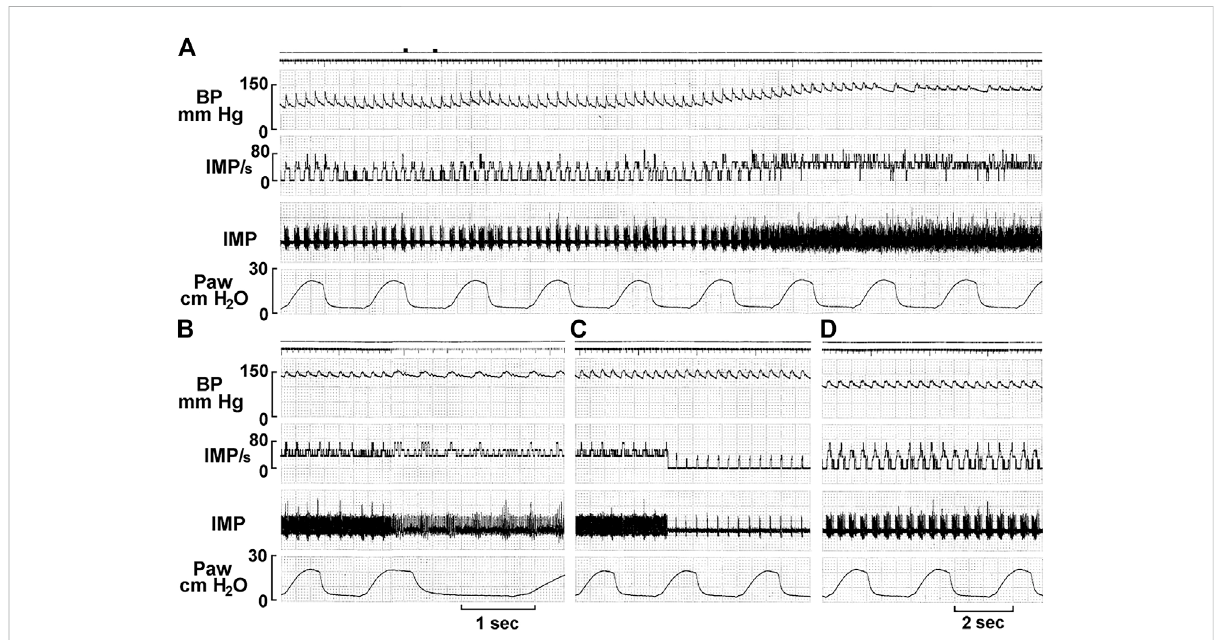
FIGURE 11 Asingleunitpossessesmultiplebaroreceptors. (A) Unitactivityofaorticbaroreceptorsrecordedfromthedepressornerveofarabbit.Thetraces from top to bottom are: arterial blood pressure, impulse activity per second, impulse activity, and airway pressure. The time elapsed between (A – D) were 50, 50, and 430 s, respectively. The two black markers on the top of A indicate injection of a vasopressor (phenylephrine, 10 mM, 0.2 ml). Unit activityincreasedasBPincreased (A) ,anddischargedcontinuouslyathigherfrequencyfor129 sandthenabruptlydecreased (C) ,withactivities in phase with cardiac rhythm. Please note that the dischargefrequency is low even though BP stays high at 150 mmHg, which isdue to deactivation, causing a pacemaker switch. The discharge pattern returned to normal 420 s after the deactivation (D) as the blood pressure became normal. [Figure 8 (Liu et al., 2021)]. That is, activity increases as the BP decreases, which against the doctrine that BRs are stimulated by increased pressure. This is strong evidence of MST.